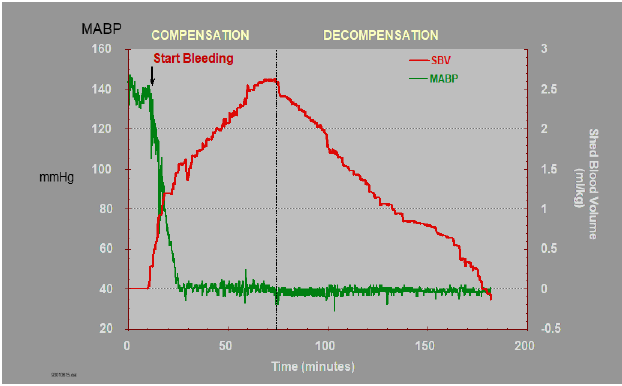
Figure 14. Phases of shock. The shock phases defined as compensatory represent the removal of 50% and 100% of peak shed blood volume (3% of body weight). Shock phases defined as decompensatory represent the return of 20 and 75% of the shed blood volume